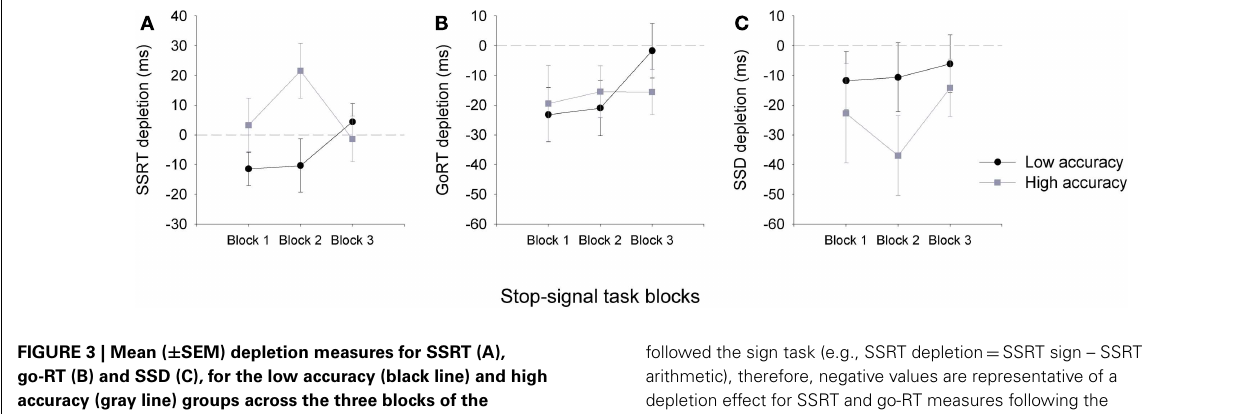
FIGURE 3 | Mean ( ± SEM) depletion measures for SSRT (A), go-RT (B) and SSD (C), for the low accuracy (black line) and high accuracy (gray line) groups across the three blocks of the stop-signal task: Block 1 (0–5min), Block 2 (5–10min), and Block 3 (10–15min). Depletion measures were calculated by subtracting SST task measures following the arithmetic task from those that